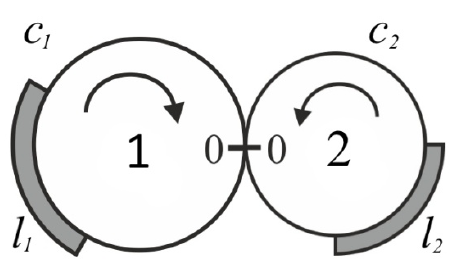
Fig. 1. A two-contours system